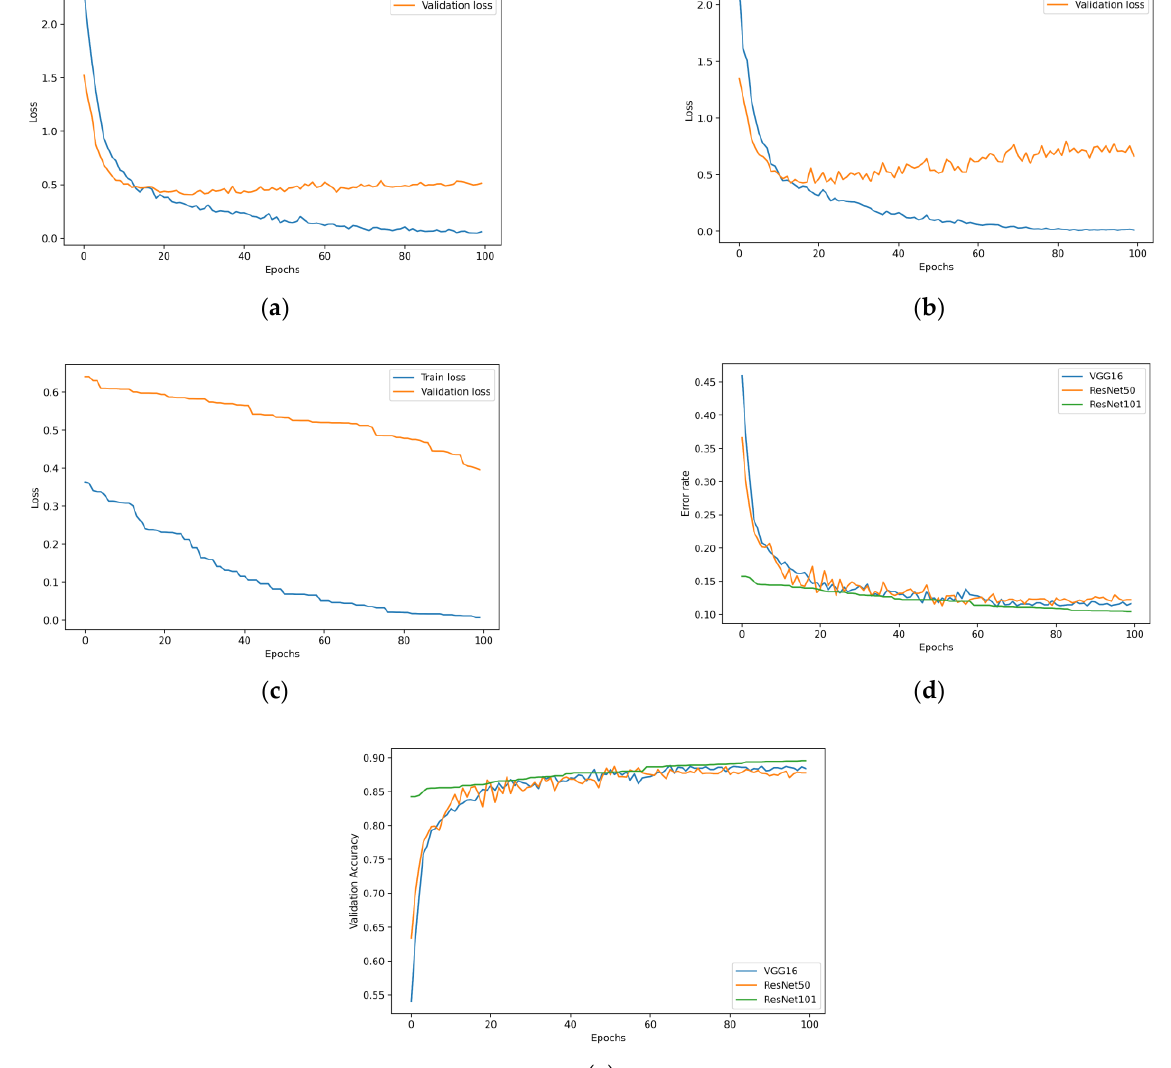
Figure 8. ( a ) Loss plot for VGG16; ( b ) loss plot for ResNet50; ( c ) loss plot for ResNet101; ( d ) error rate; and ( e ) validation accuracy of the three